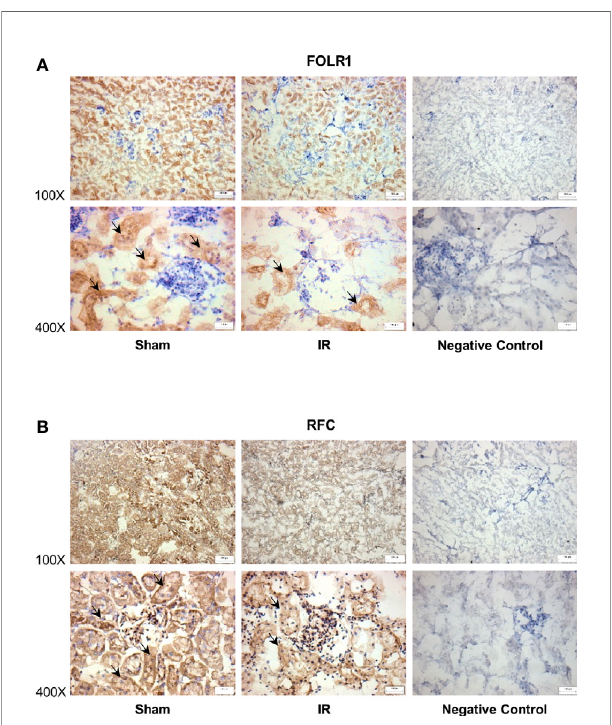
FIGURE 4 | Immunohistochemical staining offolate transporters in rat kidneys. Rats were subjected to kidney ischemia-reperfusion (IR) or sham operation (sham). Immunohistochemical staining for (A) folate receptor 1 (FOLR1) and (B) reduced folate carrier (RFC) in the kidney tissue was carried out with anti-FOLR1 antibodies and anti-RFC antibodies, respectively (magni fi cation x100 and x400). As a negative control, immunohistochemical staining was performed by using non-speci fi c rabbit IgG as primary antibodies. Arrows point to the areas stained with FOLR1 or RFC antibodies (brown color). All staining analyses were performed in kidneys isolated from 6 rats of each group. Representative photos were shown. The bar on the image represents 100 µm.